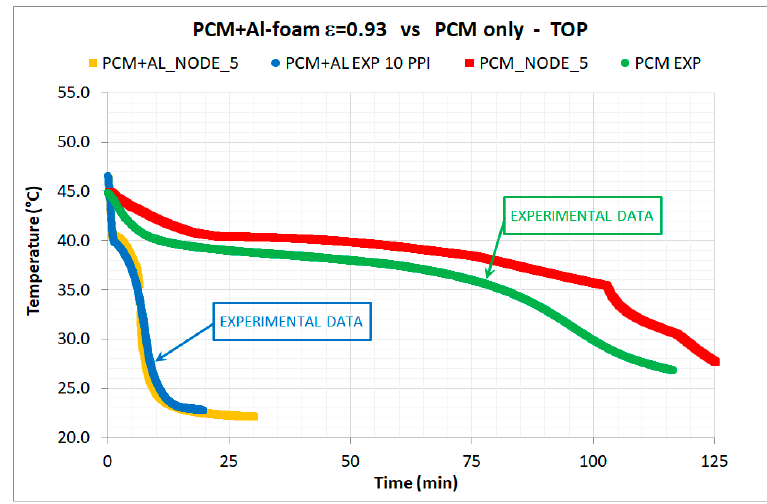
Figure 4. Temperature profiles (axial node 10 at the top of the tubes) during the unloading process of paraffin/Al-foam composite PCM and pure paraffin wax (simulated and experimental curves). Water temperature was kept at 23 °C. Experimental temperature was measured in the centre of the section.